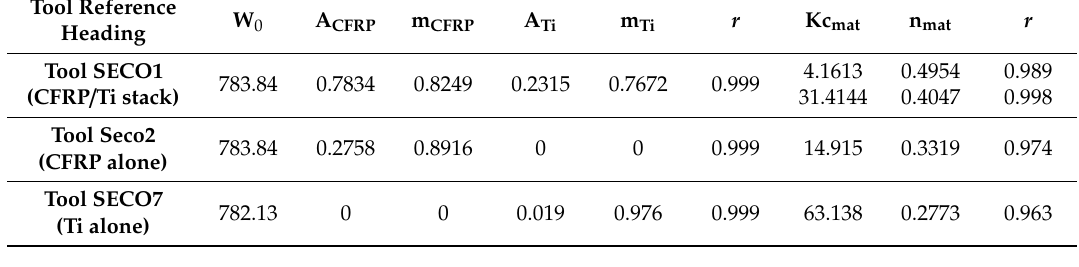
Table 4. Coe ffi cients of the models of wear and thrust force (for SECO1, upper values of Kc mat and n mat correspond to the passage in the CFRP when the lower values are related to the Ti alloy; r is the regression coe ffi cient).